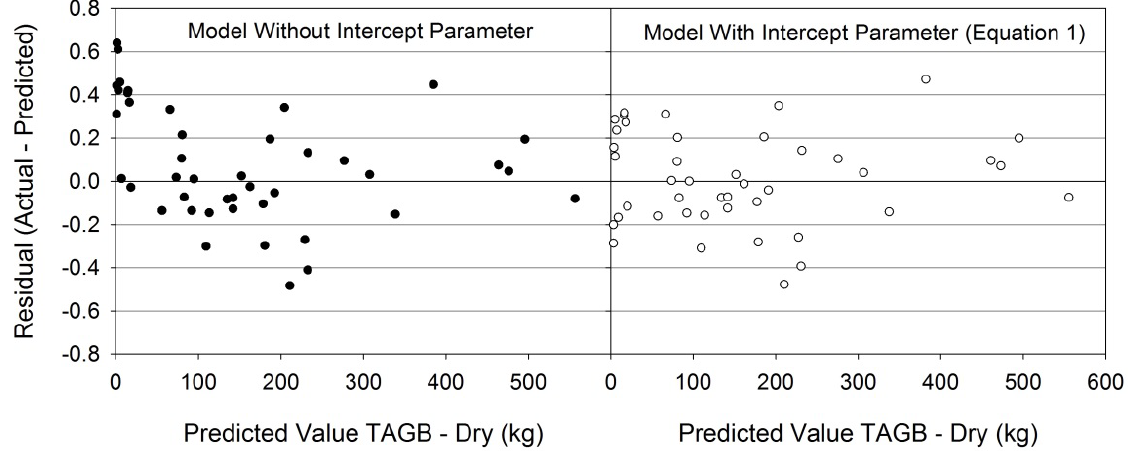
Figure 3. Residuals of two model forms evaluated for predicting total aboveground biomass (dry). A conventionally used model form [31,54] which did not include an intercept parameter appeared to underestimate TAGB in small trees (left panel). The addition of an intercept parameter to the conventional model form improved predictions for small trees (right panel). Other tree components predicted using the model with intercept parameter (Equation (1)) displayed similar residual plot improvement over the conventional model form. Table 3. Above- and belowground biomass prediction equations in green and dry condition for loblolly pine on reclaimed mineland in east Texas. Model forms are displayed in Table 2. Model Condition Component Parameter Estimate SE ADJ R 2 RMSE (kg) Weight (Table 2) Green * TAGB 1